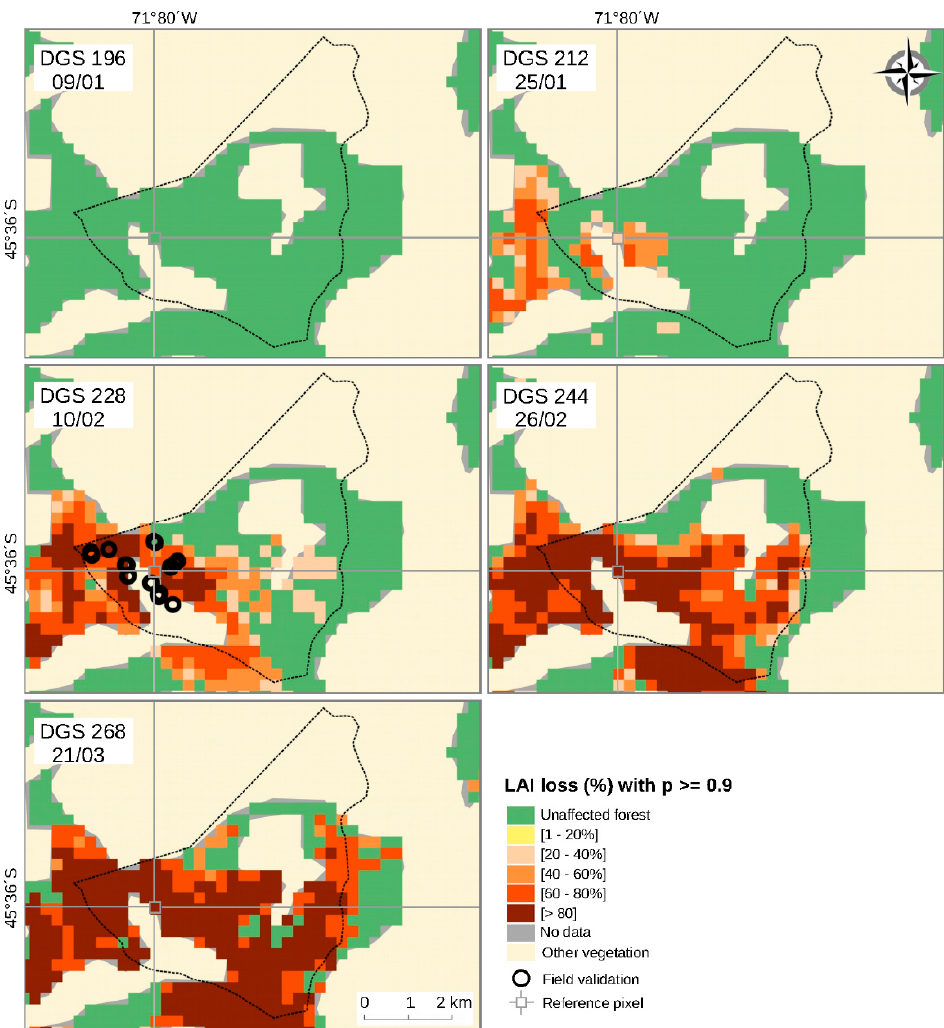
Figure 8. Spread of the insect outbreak during the growing season 2015–2016 within the Trapananda National Reserve. The reference pixel is the location of the time series shown in Figure 3. Black circles show the location of field observation of total defoliation caused by O. amphimone caterpillars.